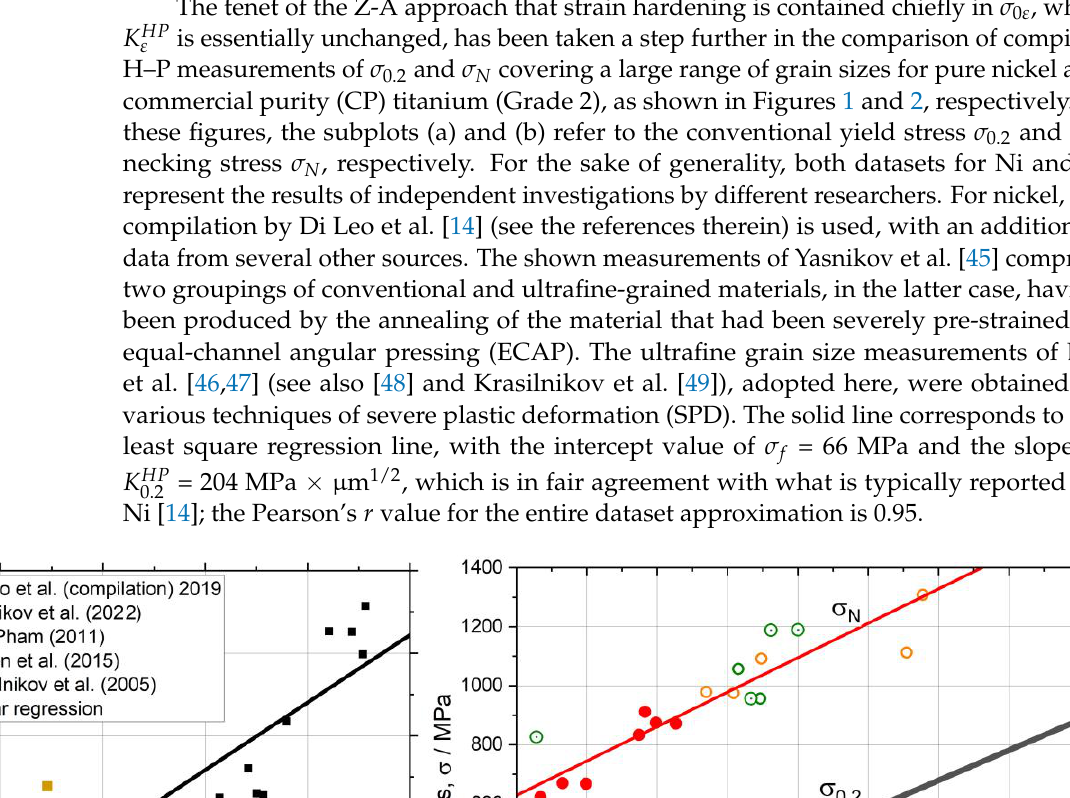
Figure 1. Hall–Petch plots showing the grain size dependence of ( a ) the yield stress σ 0.2 and ( b ) the true stress at maximum load σ N for nickel polycrystals. The linear regression line for σ 0.2 presented in ( a ) is reintroduced in ( b ) for easier comparison. The references for the datapoints collected from different studies by Di Leo et al. (2019) are given in [14]; other points are adapted from [45–49].